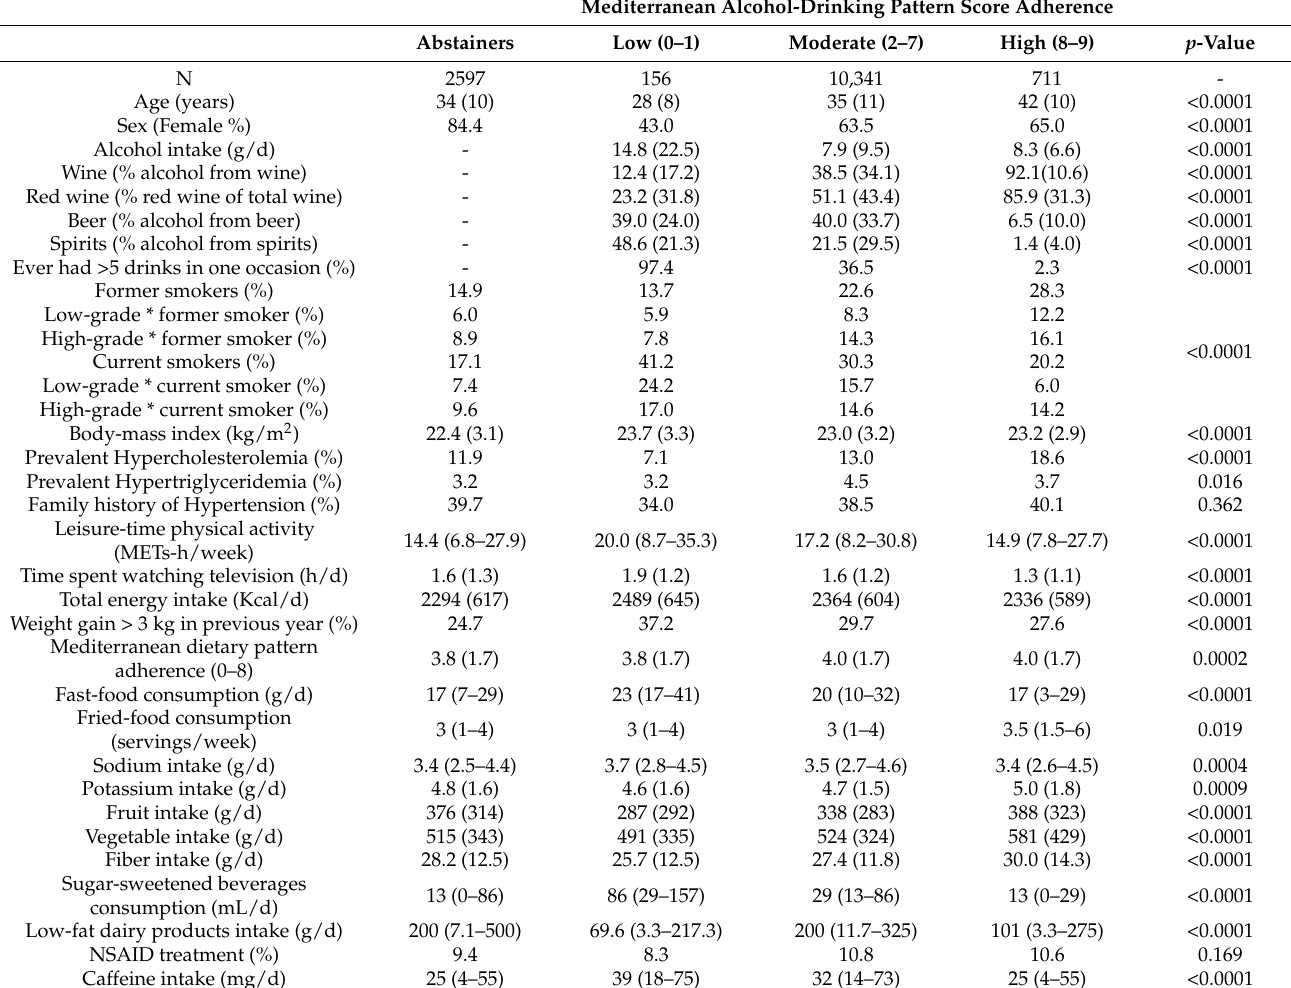
Table 1. Baseline characteristics of participants according to their adherence to the Mediterranean